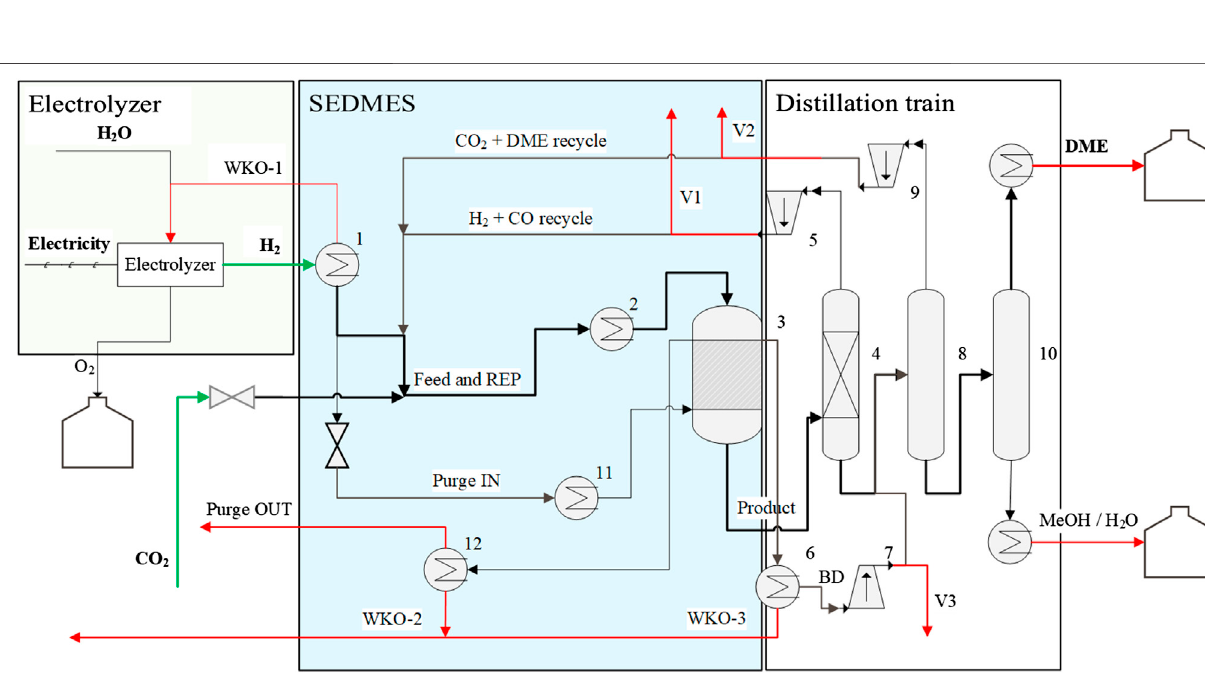
Frontiers in Chemical Engineering |